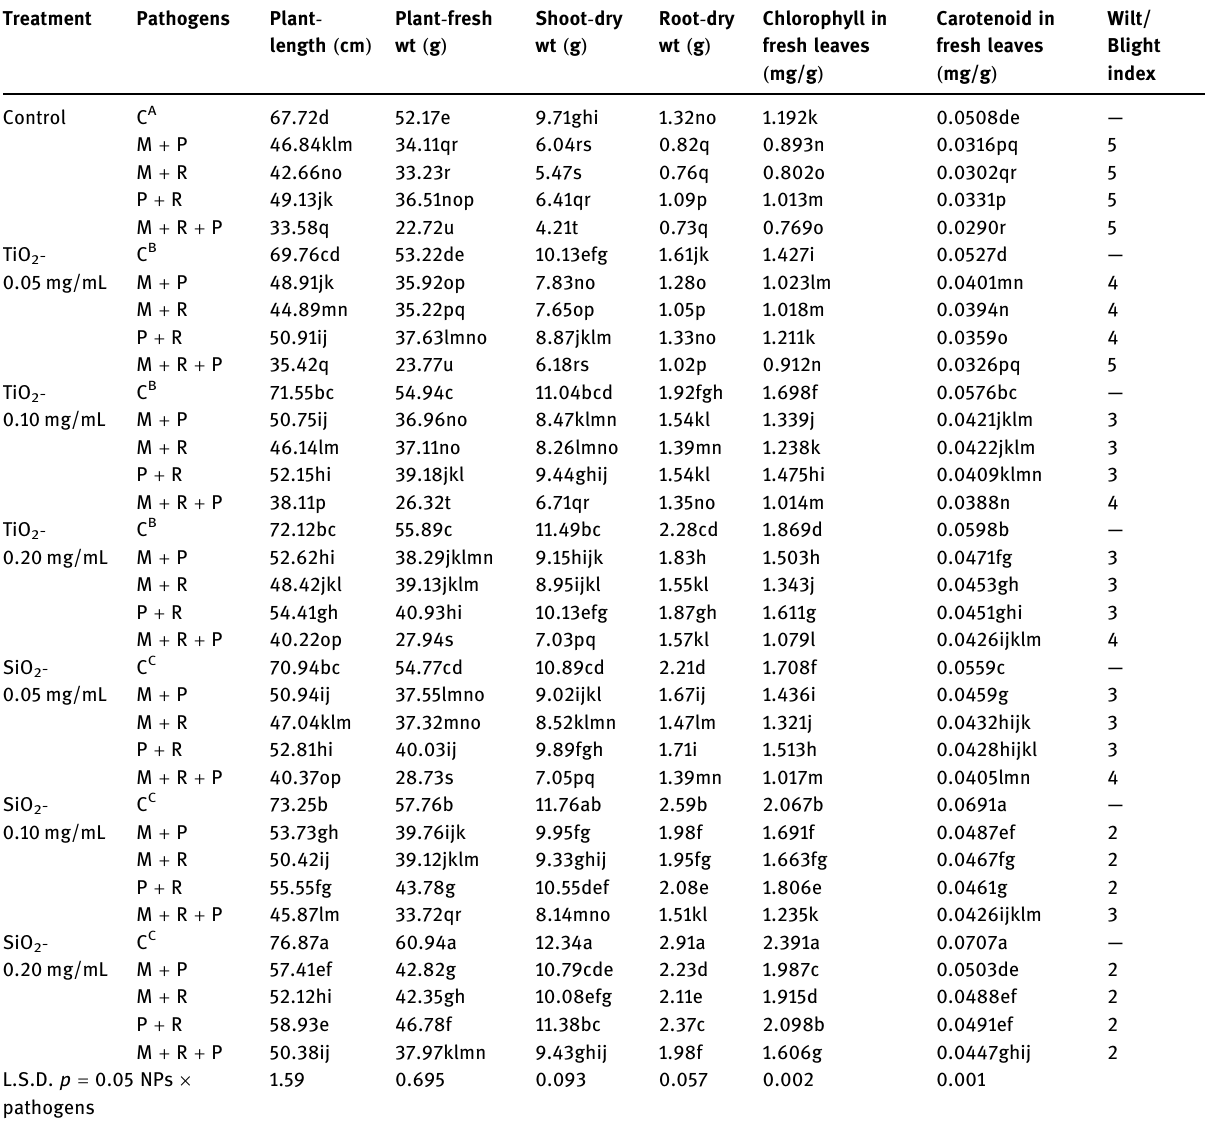
Table 5: E ff ect of SiO 2 - NPs and TiO 2 - NPs on simultaneous inoculation of P. vexans , M. incognita , and R. solanacearum , as well as plant development, chlorophyll, and carotenoid content of eggplant